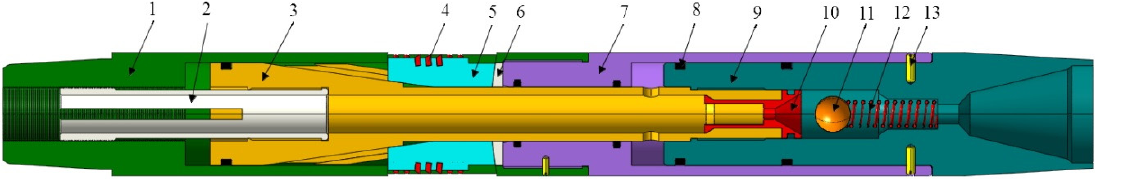
Figure 1. Inserted tooth slip packer: (1) upper cylinder body, (2) limit teeth, (3) piston, (4) carbide teeth, (5) slip body, (6) slip seat, (7) middle cylinder body, (8) O sealing ring, (9) lower cylinder body, (10) limited ball sleeve, (11) steel ball, (12) spring, (13) screw.